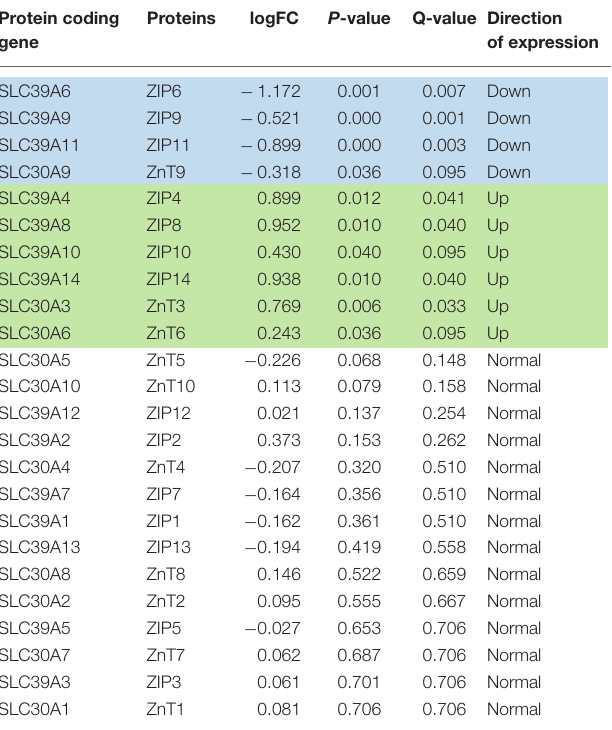
TABLE 3 | Differential gene expression analysis for ZnTs and ZIPs between the basal-like (including MDA-MB-231) and other breast cancer cell lines (Her2, Luminal A and Luminal